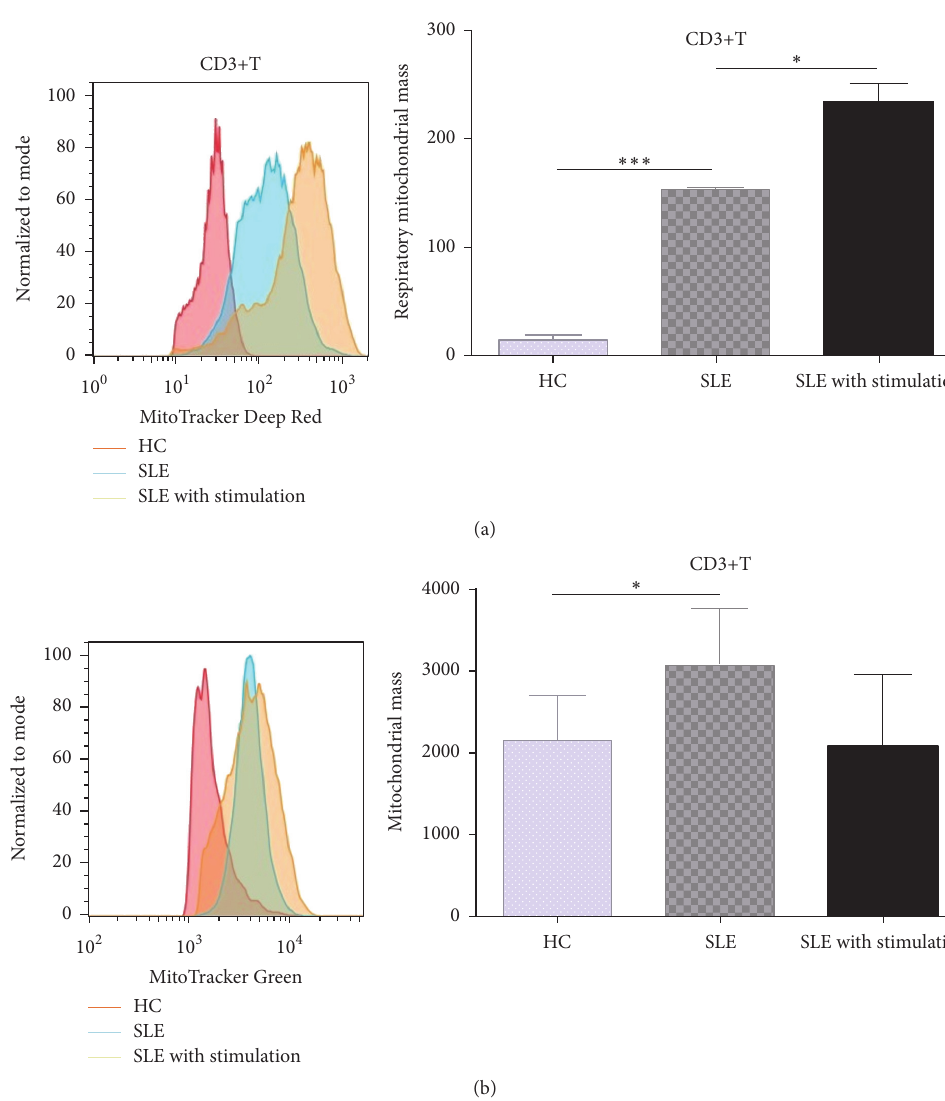
Figure 4: SLE patients had excessive mitochondria within T cells. PBMCs were stimulated with or without anti-CD3/CD28 antibodies (3 𝜇 g/mL) for 3 days. In vitro experiments were performed in triplicate. Both respiratory (a) and total mitochondrial mass (b) of CD3+T cells from systemic lupus erythematosus (SLE) patients ( 𝑛 = 9 ) were significantly higher than that from healthy controls ( 𝑛 = 5 ), and respiratory mitochondrial mass further increased following anti-CD3/CD28 activation. ∗ 𝑝 < 0.05, ∗∗∗ 𝑝 <